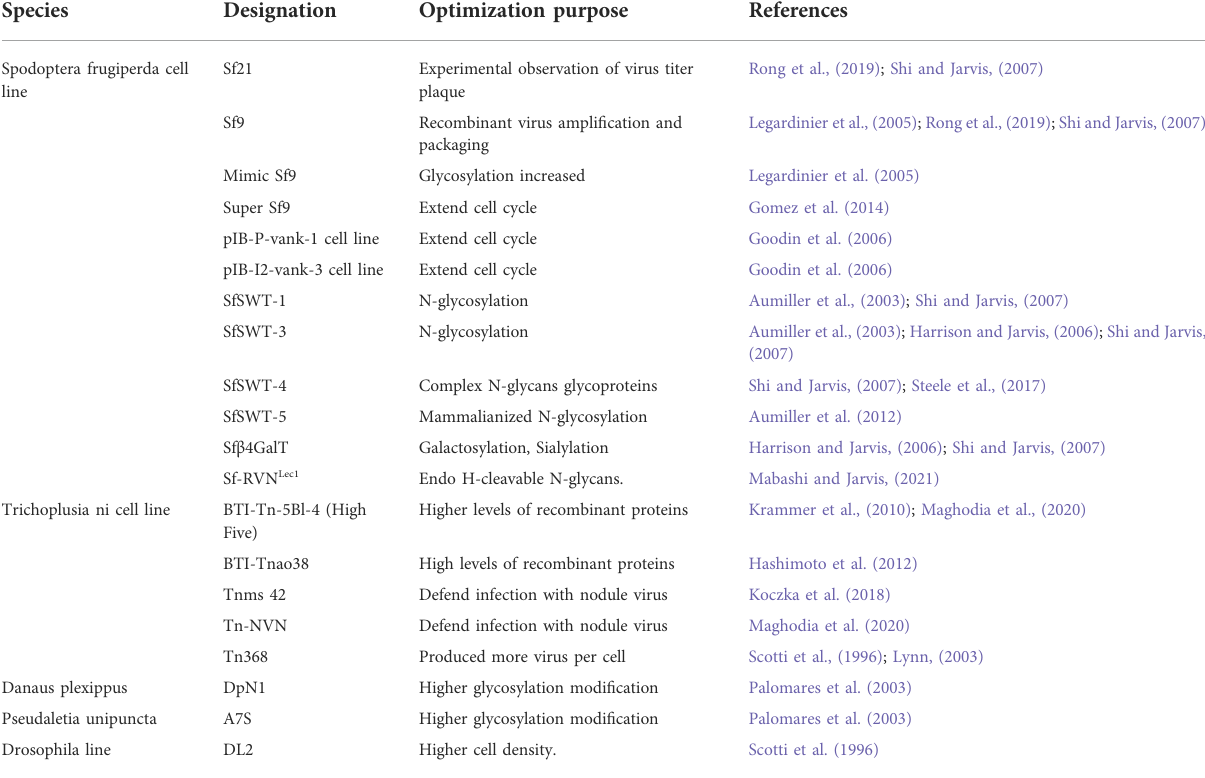
TABLE 3 Common and engineered insect cell